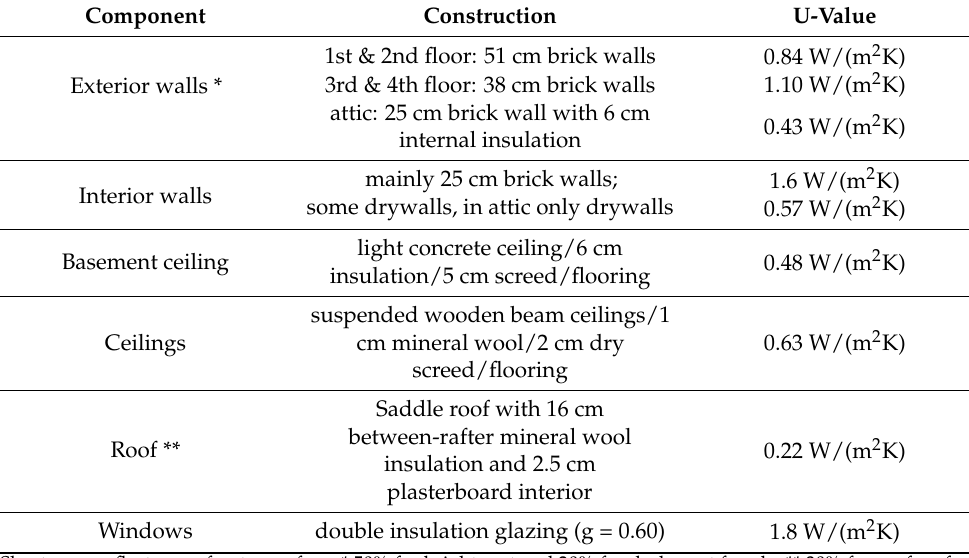
Table 1. Structural components of the investigated GZH building including U-value (heat transfer coefficient), g-value (energy transmittance of the glazing) and shortwave reflectance of the outer surfaces. Material and layer thicknesses were taken from building permission documents as well as from component thickness measurements on site. Detailed information about layer thickness, heat conductivity, density and specific heat capacity are listed in Table A3 of the Appendix